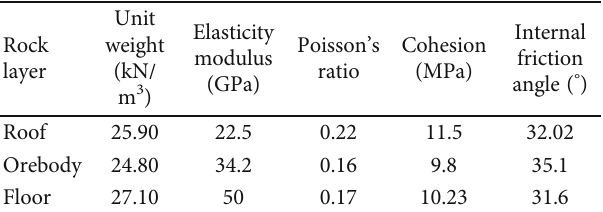
Figure 3: Numerical model of the slope with the hanging-wall ore slope. Table 1: Statistic of the test results of physical and mechanical properties of rock